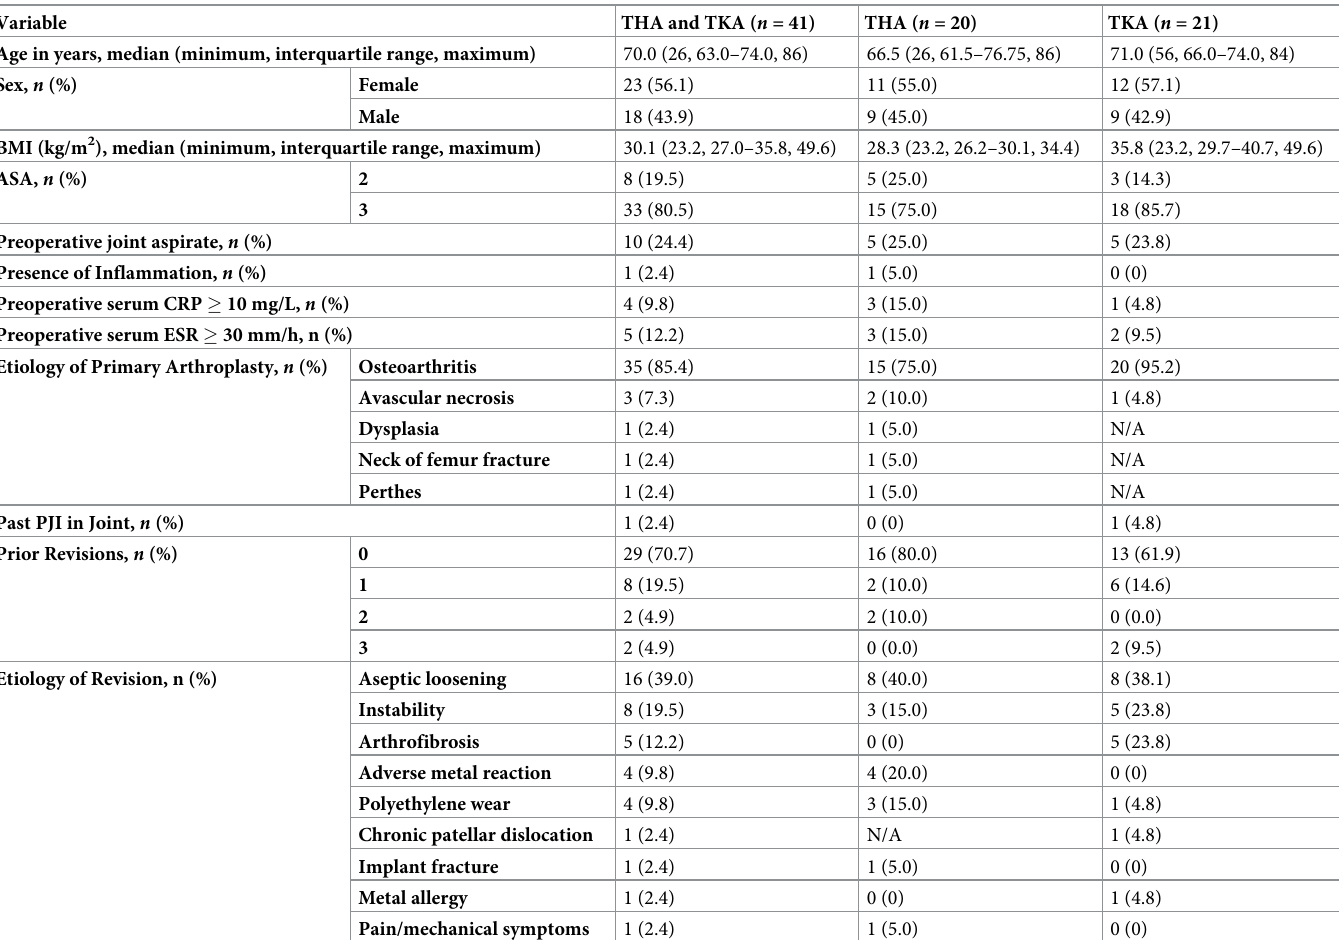
Table 1. Study participant